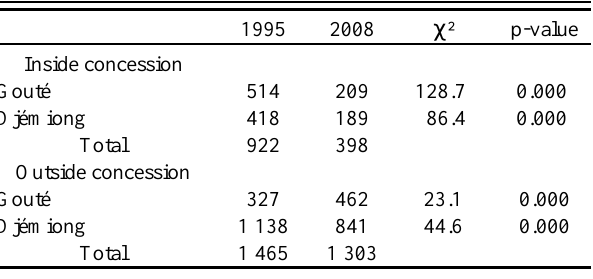
Table 4 . Location of hunting trips in the two villages in a